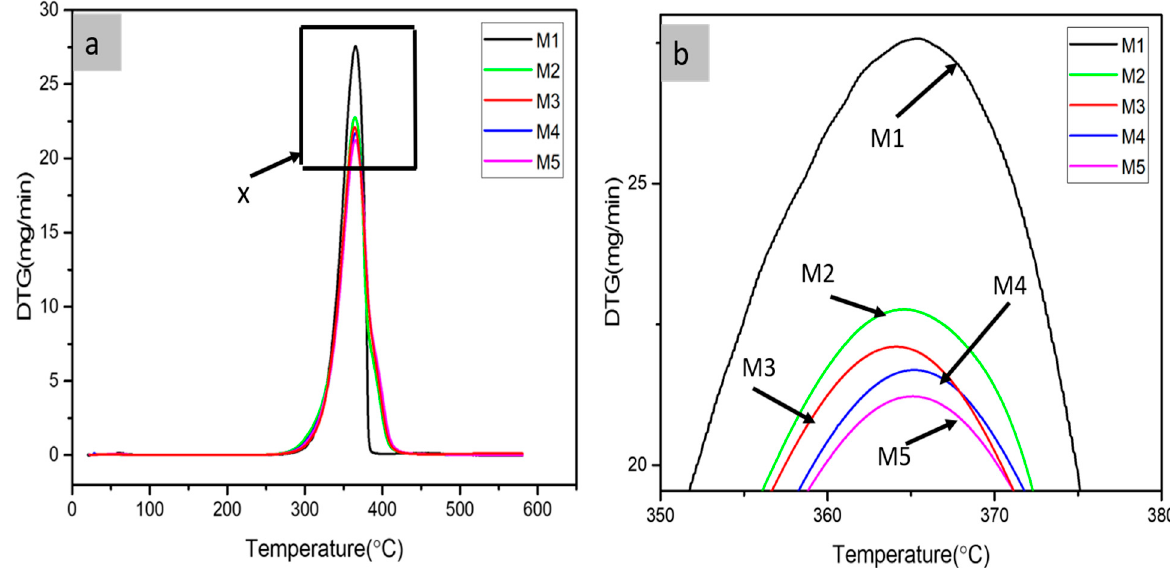
Figure 3. DTG of ( a ) PLA, PLA-PBS, PLA-PBS-MCC composite films, ( b ) zoomed x part. DSC analysis characterizes the physical nature of the material. The DSC curves displayed two thermal transition temperatures: glass transition temperatures (T g ), and the melting temperatures (T m ) with the absence of crystallization (T c ). The glass transition indicates a change of the degree of freedom of the molecules in the amorphous regions on increasing temperature in the polymer matrix [31]. Figure 4a,b demonstrates the DSC thermograms behavior of the composite films.